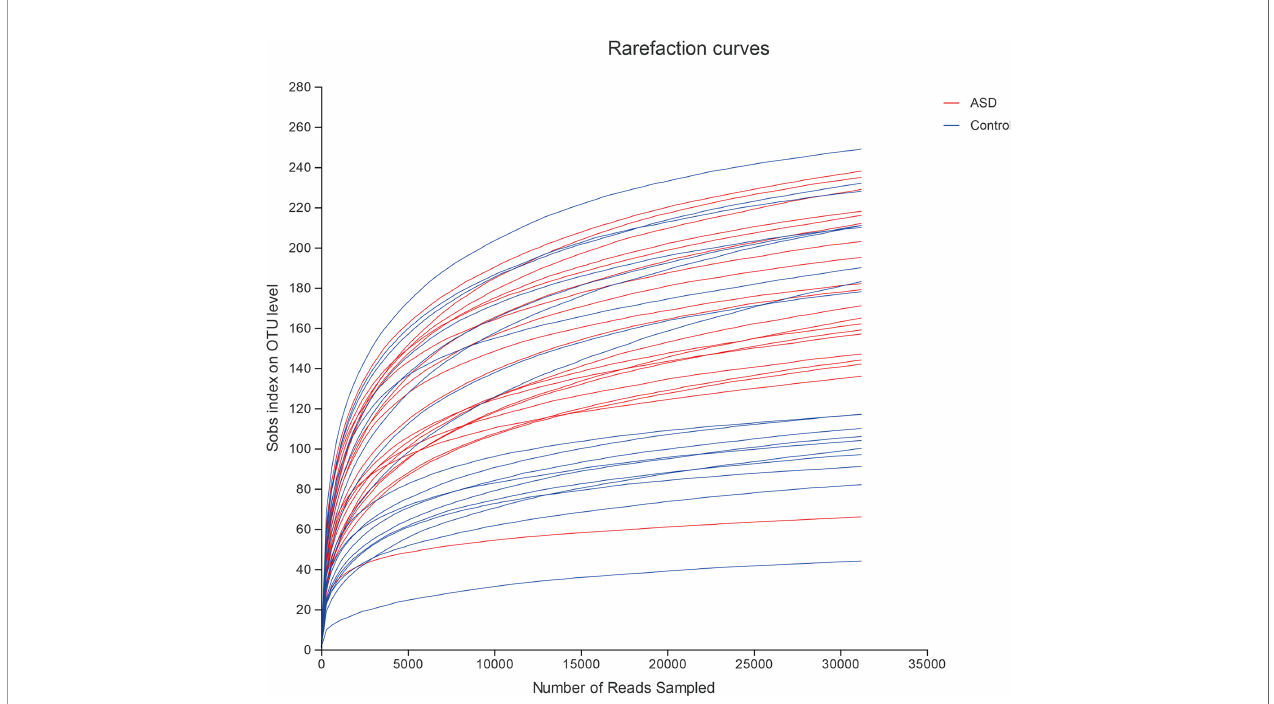
FIGURE 1 | The bacterial community richness was analyzed by rarefaction curves (red: ASD group; blue: control